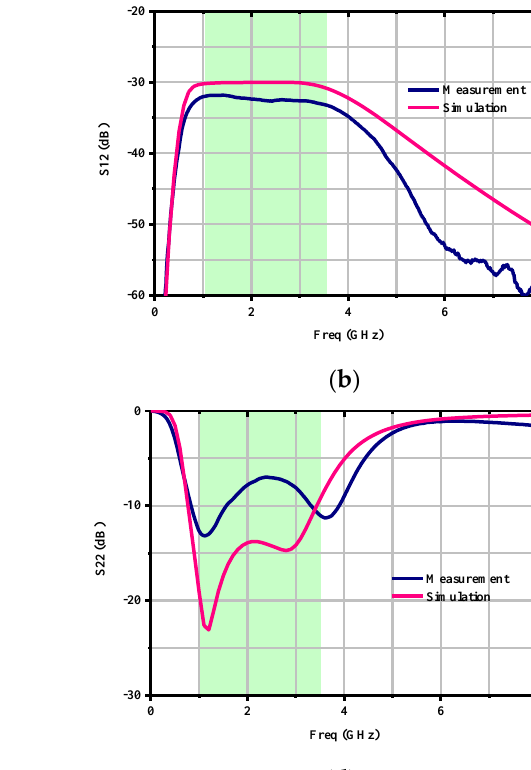
was registered in the range from 1 GHz to 3.5 GHz, shown in Figure 10. Compared with simulation data, the measured NF was about 0.1 dB higher. This was caused by the dif- ference between the device and model . And the simulation could not simulate the real conditions of the working device absolutely. Figure 9. Scattering parameters of the proposed LNA ( a ) S21; ( b ) S12; ( c ) S11; ( d ) S22. From Figure 9, a peak gain of 25.8 dB was measured at 1.2 GHz, which is 1.4 dB lower than the simulated result. Measured S11 and S22 was lower than − 20 dB and − 7 dB from 1 GHz to 3.5 GHz. As far as S11 and S22 are concerned, the difference between simulation and measurement can be ascribed to the input and output connector and to the coupling parasitic between the devices. The S12 data is lower than −3 0 dB in the frequency band, indicating that the amplifier had a high level of reverse isolation making the LNA uncon- ditionally stable. Measured scattering parameters demonstrated that the BPDWB network had good prediction accuracy for RF LNA.